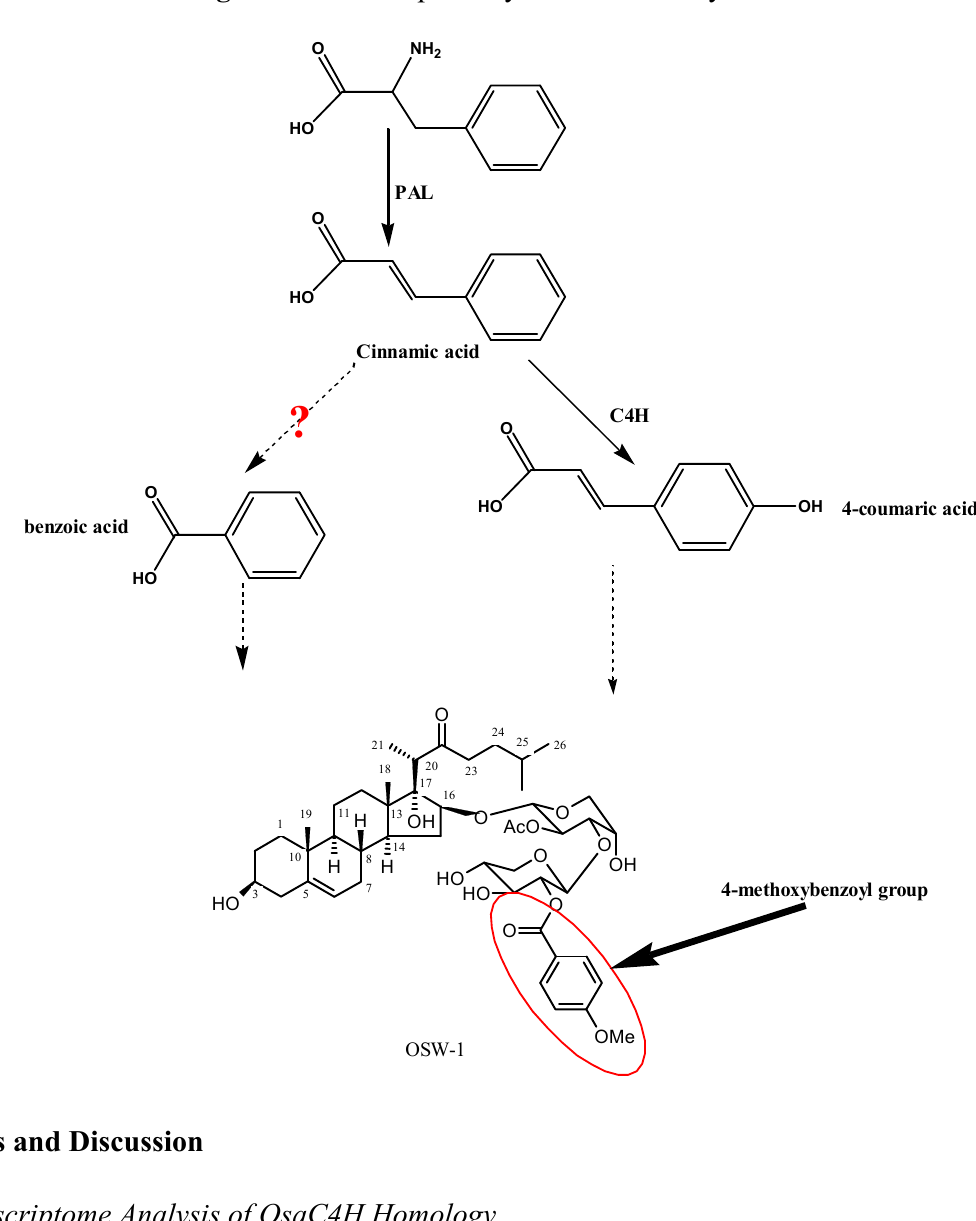
Figure 1. Putative pathway of OSW-1